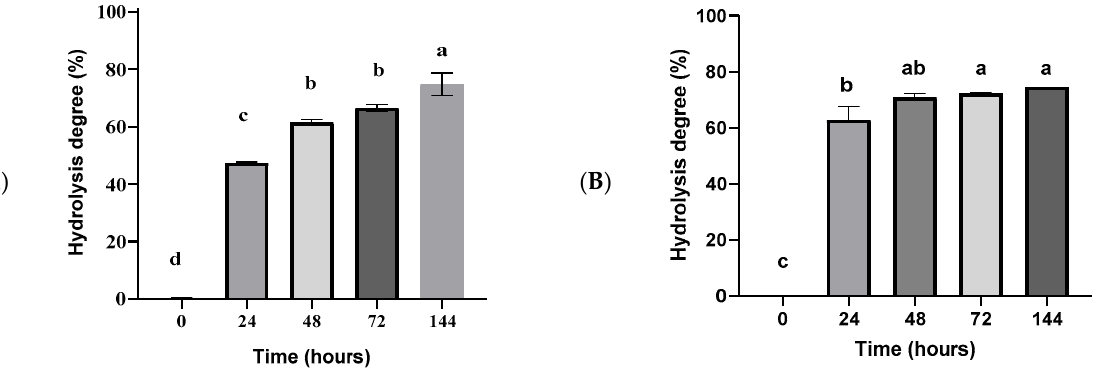
Figure 6. Hydrolysis of fish oil after the application of the crude enzymatic extract ( A ) and using the solid biocatalyst stored for 7 months at room temperature ( B ), both produced by Yarrowia lipolytica . Data followed by the same lowercase letters are not significantly different ( p > 0.05).